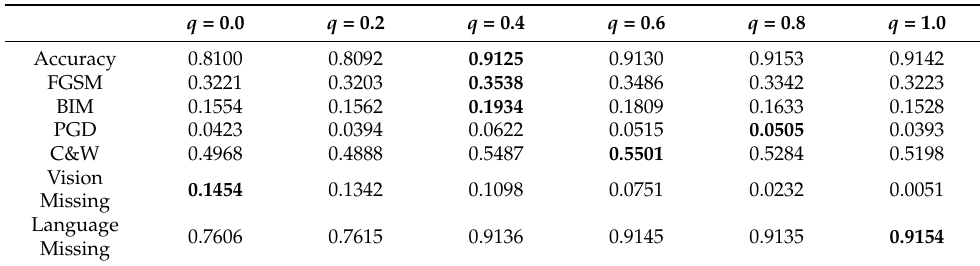
Table 8. Accuracy averages for different cases with different values visual modal integrity probability parameter q for the Birds dataset.